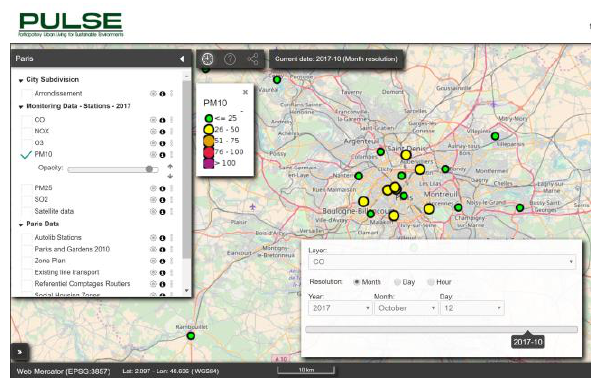
Figure 2. Another part of the PULSE WebGIS, that shows data coming from air quality sensors in the city of Paris. On the bottom right it is possible to see the temporal bar, that allows to navigate data in time and choose the temporal granularity